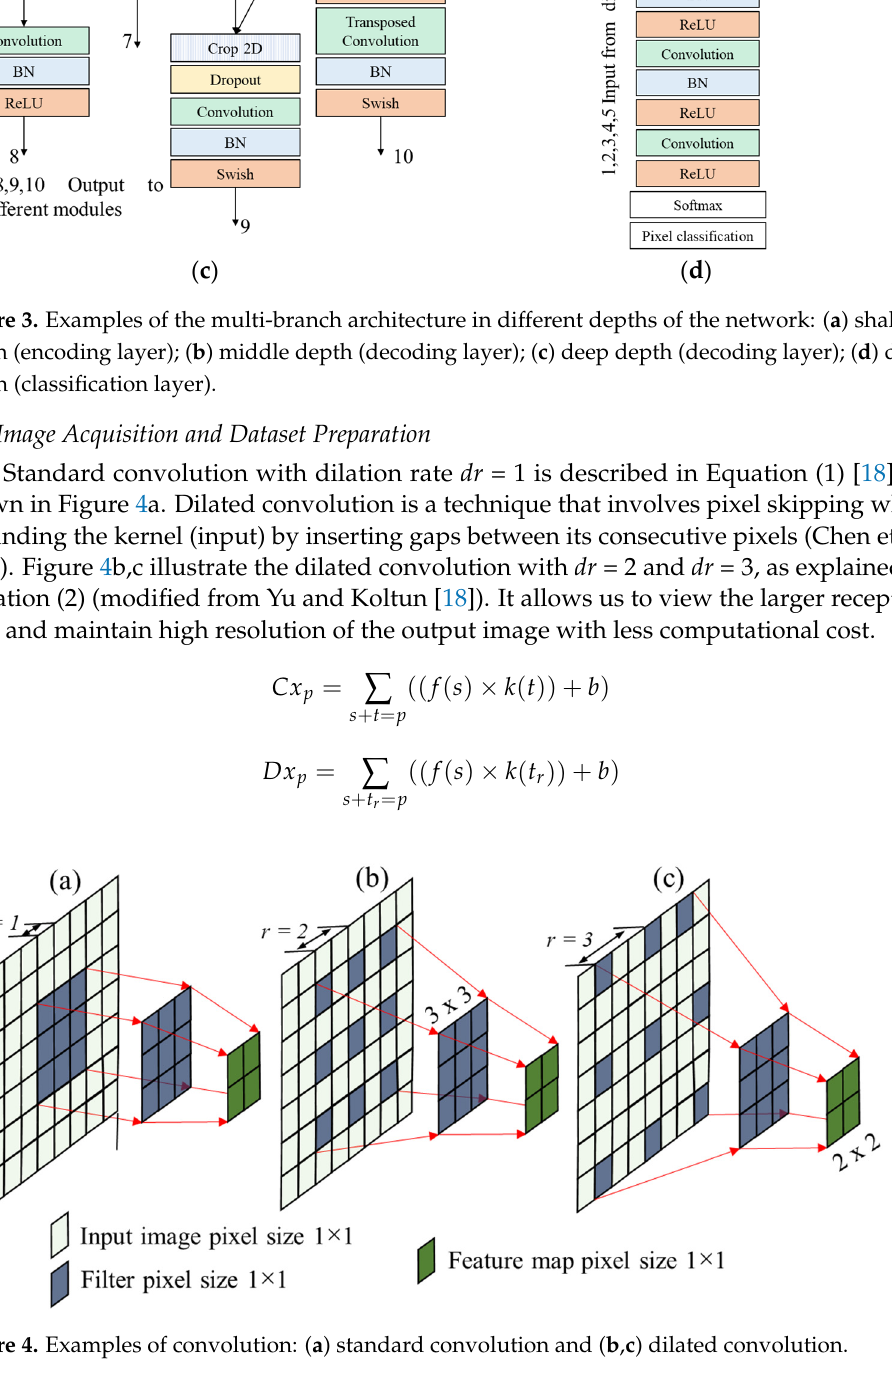
Figure 4. Examples of convolution: ( a ) standard convolution and ( b , c ) dilated convolution.